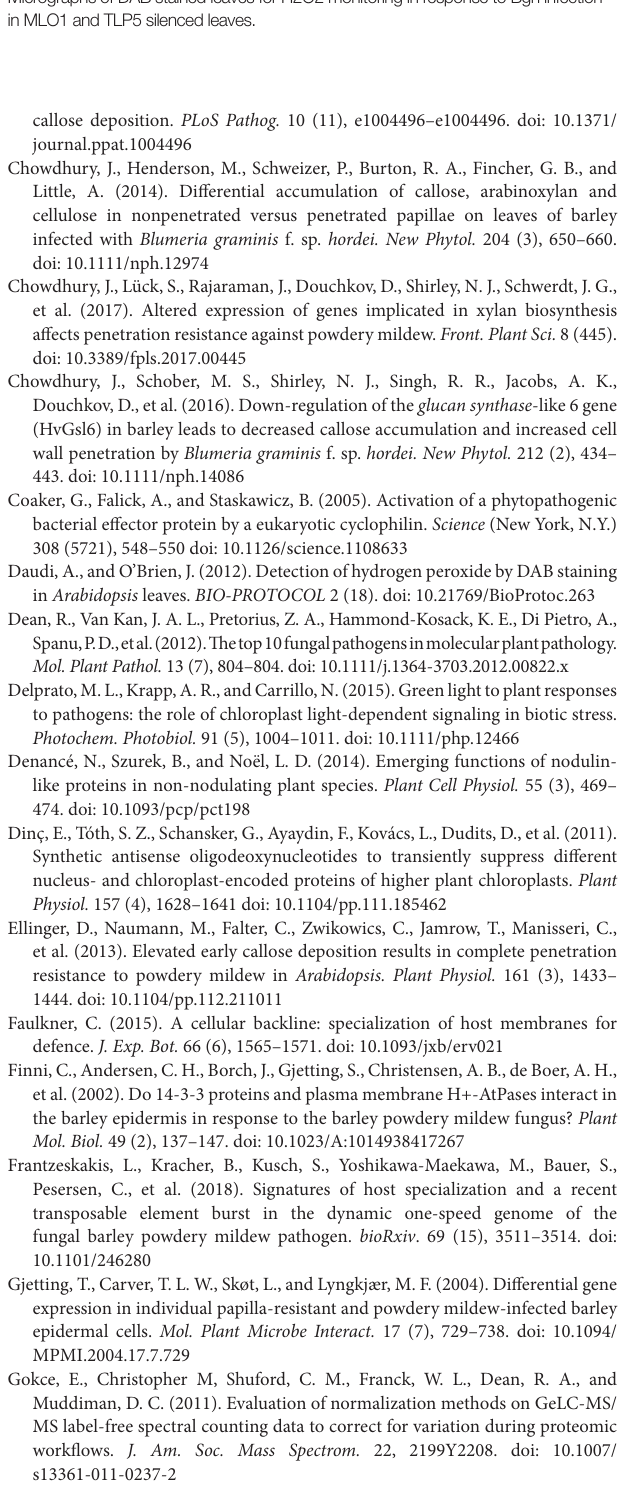
SUPPLEMENTARY MATERIALS S1 | Proteomics data analysis: Mascot results indicating protein IDs and normalised Spectral counting data for protein quantification. SUPPLEMENTARY MATERIALS S2 | Gene ontology and protein cellular compartment predictions. SUPPLEMENTARY MATERIALS S3 | Protein sequence and homology information of TLP5 and other PR5